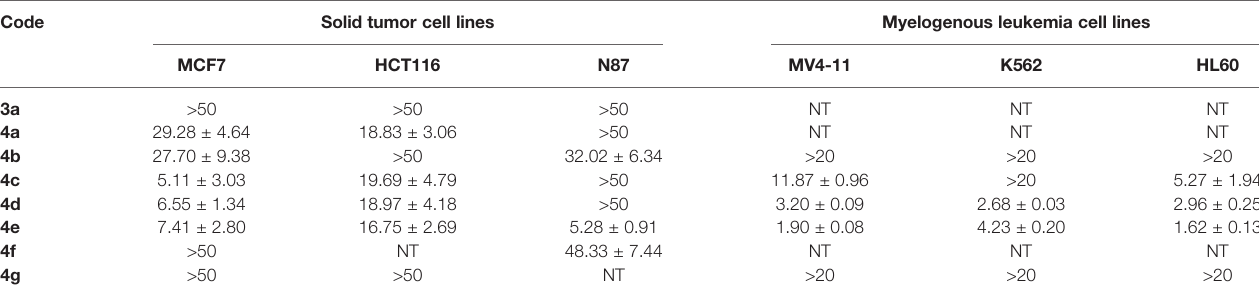
TABLE 1 | Results of cytotoxic activities of compounds against variety of cancer cell lines expressed as IC 50 ± SEM (µM). Code